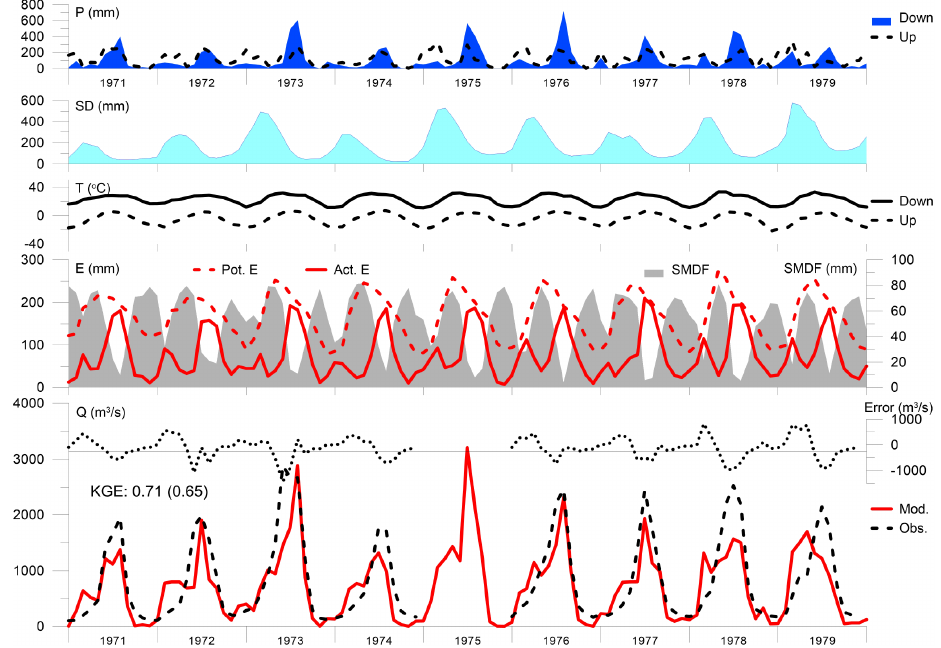
Figure 10. Analysis of model variables at the Akhnoor station (Chenab River; asterisk 3 in Fig. 2): P , SD, T , E , SMDF and Q . E corresponds to potential (Pot.) and actual (Act.) evapotranspiration, and Q corresponds to modelled (Mod.) and observed (Obs.) discharge). Note that P and T series are plotted at the outlet of the basin (Down) and the most upstream subbasin (Up).